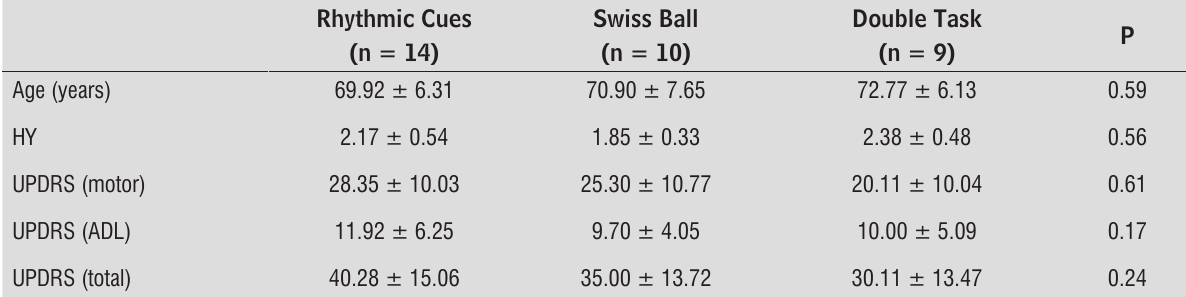
Table 1 - Characteristics of participants